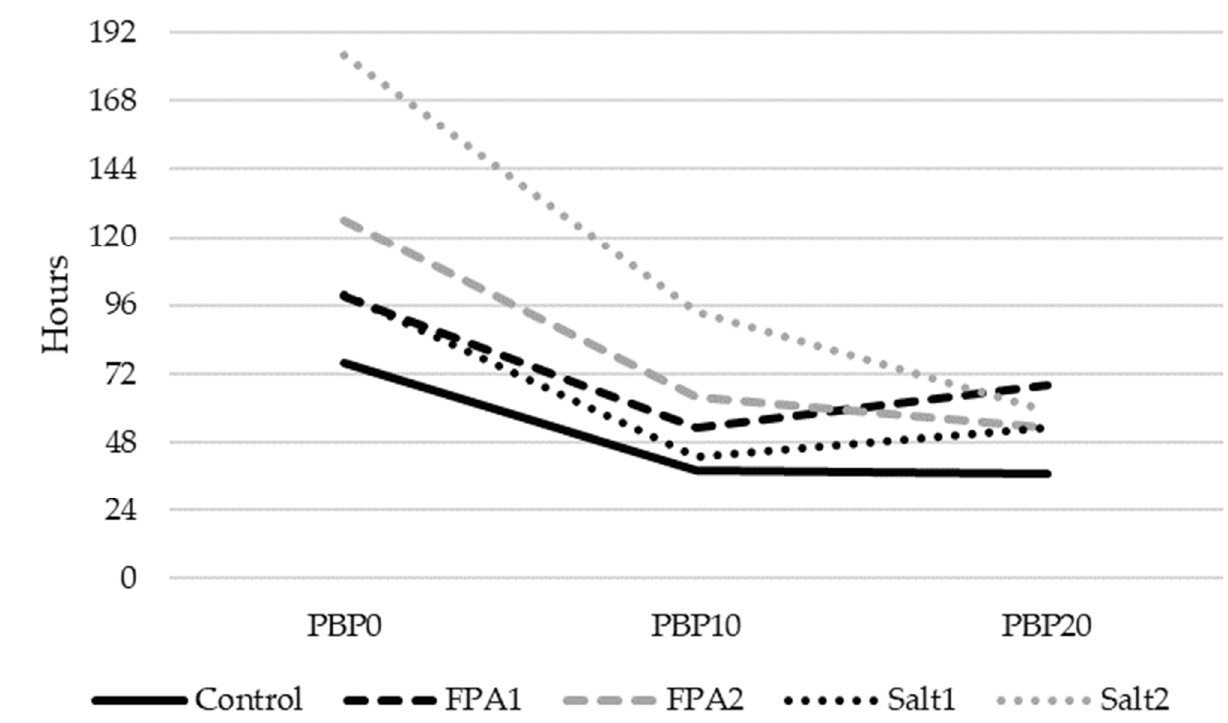
Figure 1. Aerobic stability (2 °C above room temperature) of total mixed rations with incremental proportions (0, 10 or 20 g/kg dry matter) of potato by-product (PBP) and treated with formic and propionic acid-based (FPA) or salt-based (Salt) preservatives at 1.5 (FPA1 and Salt1) or 3 (FPA2 and Salt2) liters per ton (Experiment 2).